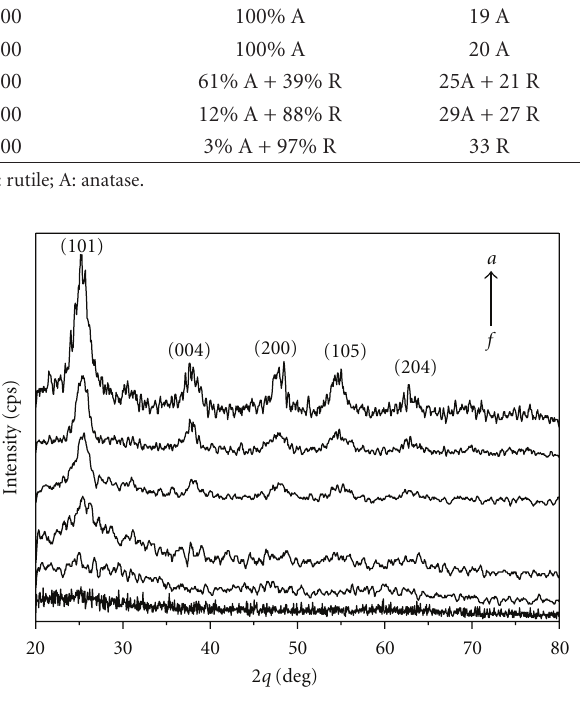
Figure 5: XRD patterns of TiO 2 precursor aged at 65 ◦ C for (a) 0 h, (b) 6 h, (c) 12h, (d) 48h, (e) 90 h, (f) 135